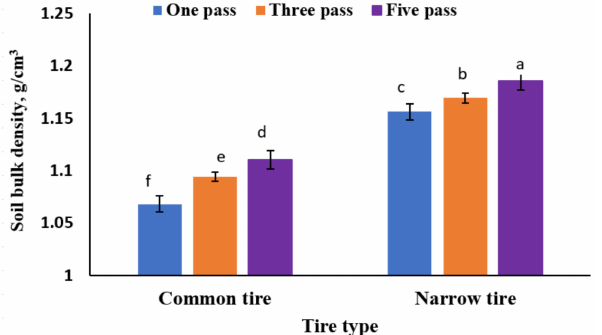
Figure 7. The main effect of tire type and traffic on soil bulk density (different English alphabets shows significant difference between treatments).